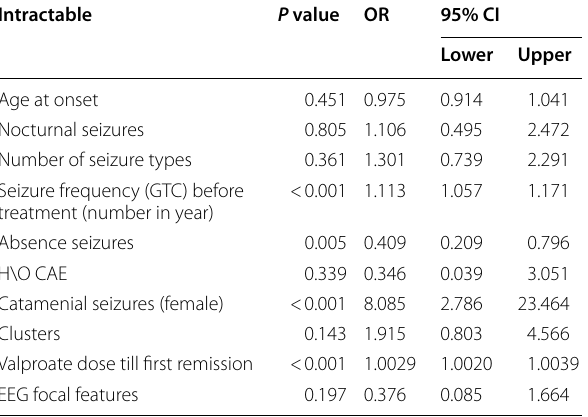
Table 1 Clinical data of the study population